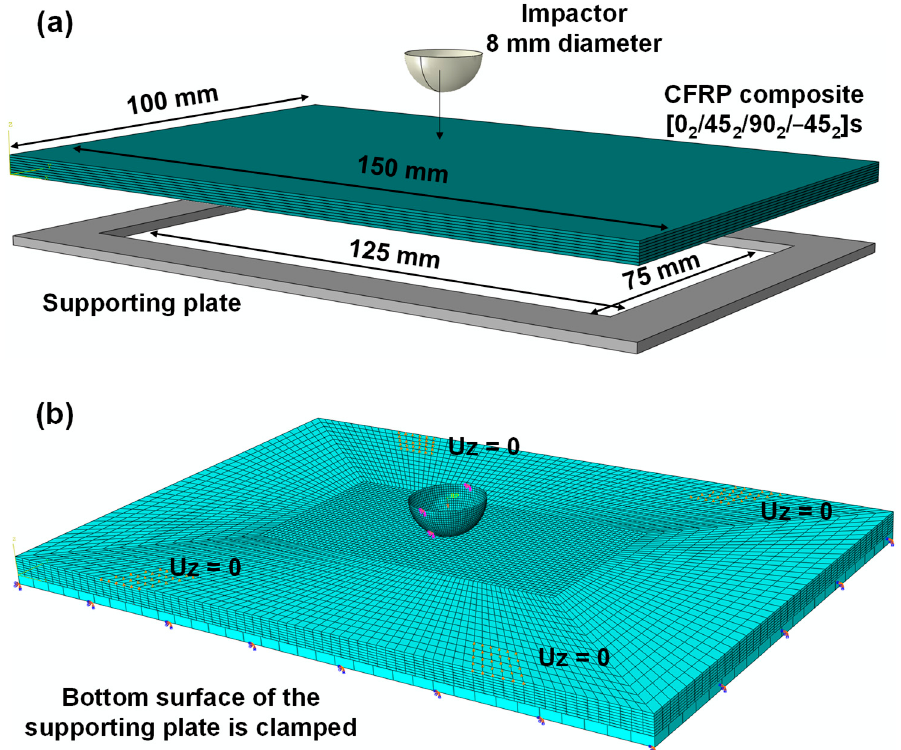
Figure 3. Verification of the low velocity impact model using a benchmark simulation problem for a CFRP composite laminate under an impact energy of 25 J: ( a ) problem setup and ( b ) mesh and boundary conditions used in the finite element analysis. Note: the x direction represents the longitudinal direction or direction 1, y direction represents the transverse direction or direction 2, and z direction represents the through-thickness direction or direction 3 in the laminate coordinate system.